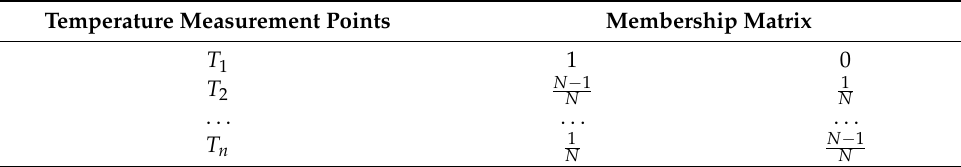
Table 1. Initialization of membership